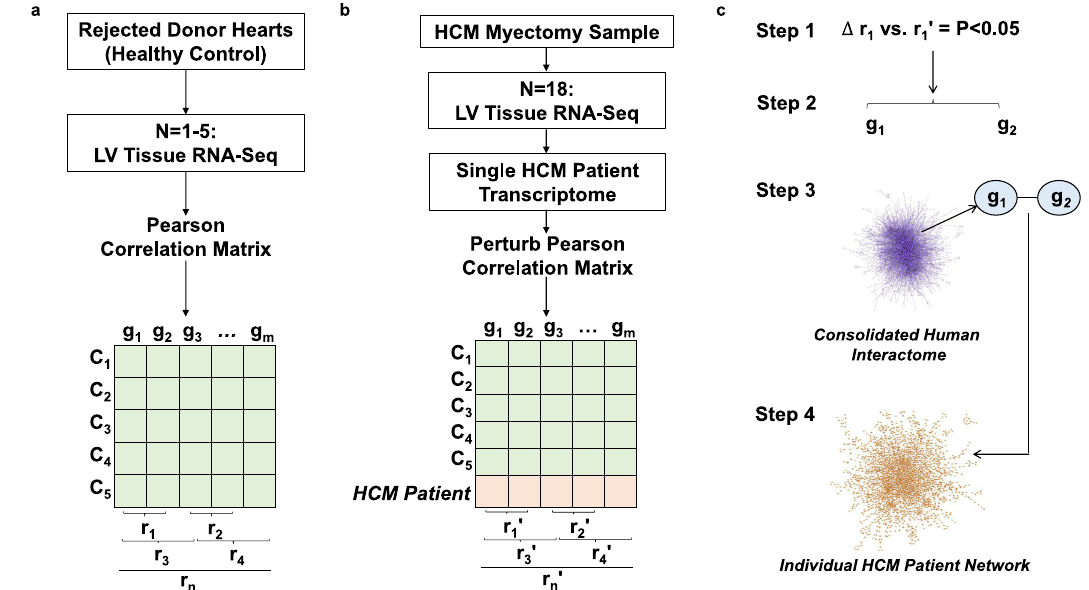
Fig. 1 Strategy for developing patient-speci fi c protein – protein interaction networks in HCM. a Left ventricular (LV) myocardial samples from rejected heart transplant donors serving as healthy controls ( N = 5) (C 1 – C 5 ) were analyzed using RNA-Seq, and the Pearson correlation coef fi cient ( r ) was calculated for all gene ( g ) pairs. n, total combination of pairwise correlations; m, total number of genes. b Anterior septal myectomy samples from hypertrophic cardiomyopathy (HCM) patients were analyzed using RNA-Seq. The transcriptomic pro fi le of an individual HCM patient was added to the control gene expression matrix, and the new Pearson correlation coef fi cient (r ′ ) was calculated for all gene pairs. The HCM patient transcriptomic pro fi le was then removed from the matrix and the process was repeated sequentially for the HCM ( N = 18). c (Step1) Statistically signi fi cant changes between the r and r ′ coef fi cients were collected, and (Step 2) those gene pairs (g 1 – g 2 ) were mapped to the consolidated human interactome (Step 3), which contains information on 15,489 proteins and 188,973 protein – protein interactions (PPIs). The statistical test used in this step was the two-tailed Z -test, and the P values were adjusted by the Bonferroni correction procedure for multiple comparison. In Step 4, gene pairs for which a PPI was identi fi ed in the consolidated human interactome were used to generate individual-patient PPI network